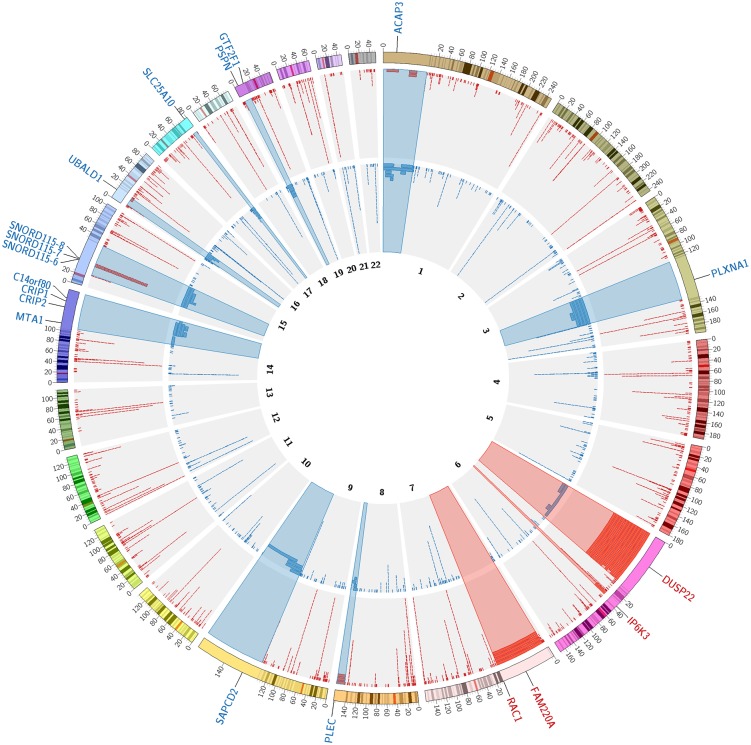
Chromosome view of detected CNVs.The CNVs are presented as tiles on the corresponding genomic positions. The colour of the tile indicates the CNV type: deletions are red, duplications are blue. The height of tile stack in each genomic region corresponds to the number of CNVs; if genomic region contains more than 25 CNVs, only 25 tiles are presented. The genes intersected by rare CNVs and significantly (Padj<0.01) associated with IBD are marked by red (for deleted genes) or blue (for duplicated genes) labels; the colocated genes overlapped by the same CNVs with no significant IBD association are not presented. The regions contained the genes intersected by rare CNVs significantly associated with IBD are zoomed in 1000 times and highlighted (red and blue highlights for the associated deletions and duplications, correspondingly). The figure was built using the Circos[35] tool.